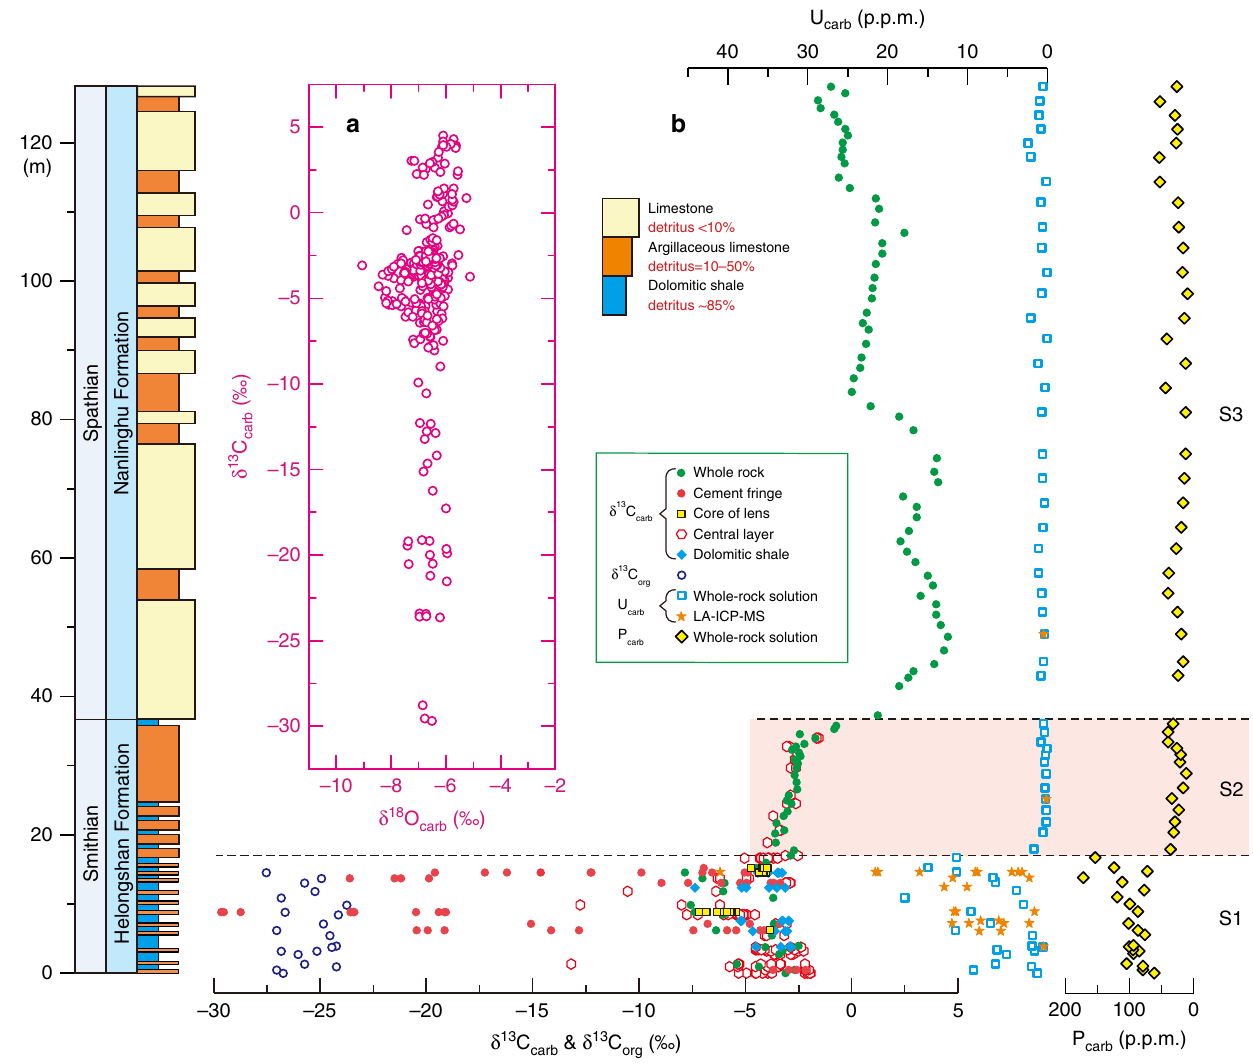
Figure 1 | Geochemical results of sedimentary carbonates from the Yindushan section. ( a ) A d 13 C carb – d 18 O carb cross-plot for all samples. ( b ) Stratigraphic variations of d 13 C carb , d 13 C org , P carb and U carb . S1, S2 and S3 represent three stratigraphic intervals divided by d 13 C carb